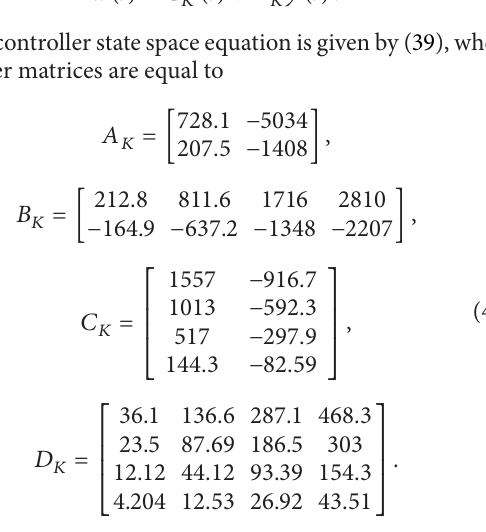
Figure 18: Beam free end displacement, with and without HIFOO control.